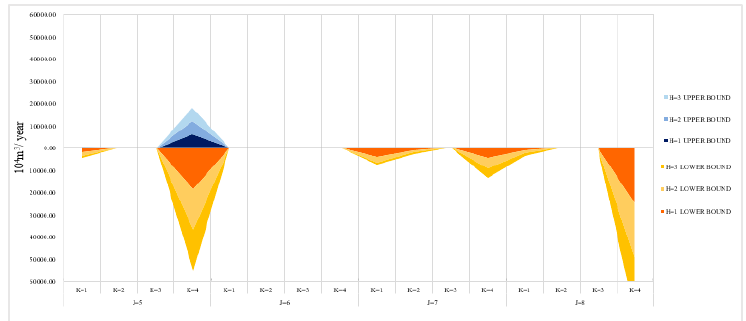
Figure 12. Water shortage in different water use departments in different situations in the second planning period.